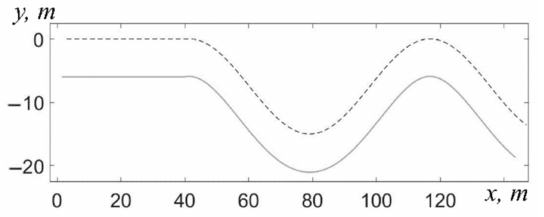
Figure 5. The desired trajectories of AUV-leader and